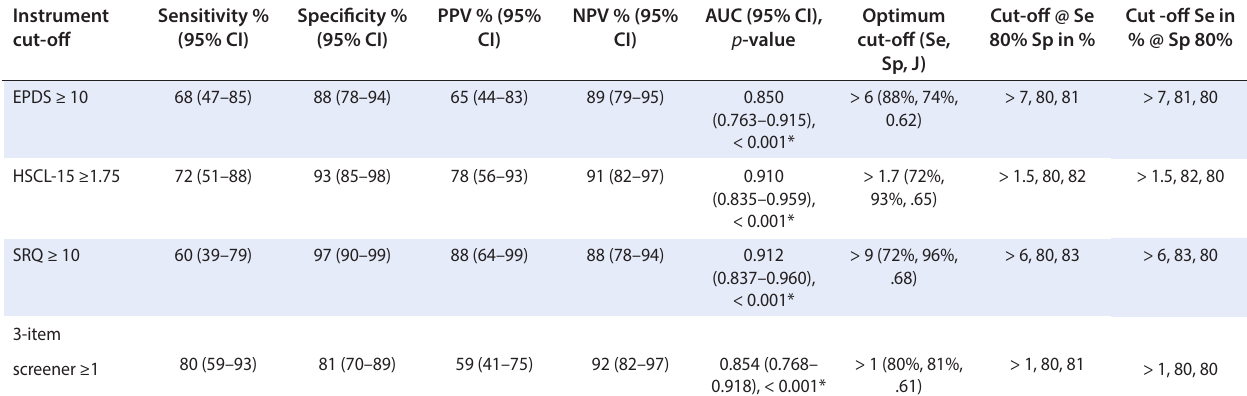
Table 2: Validity of screening